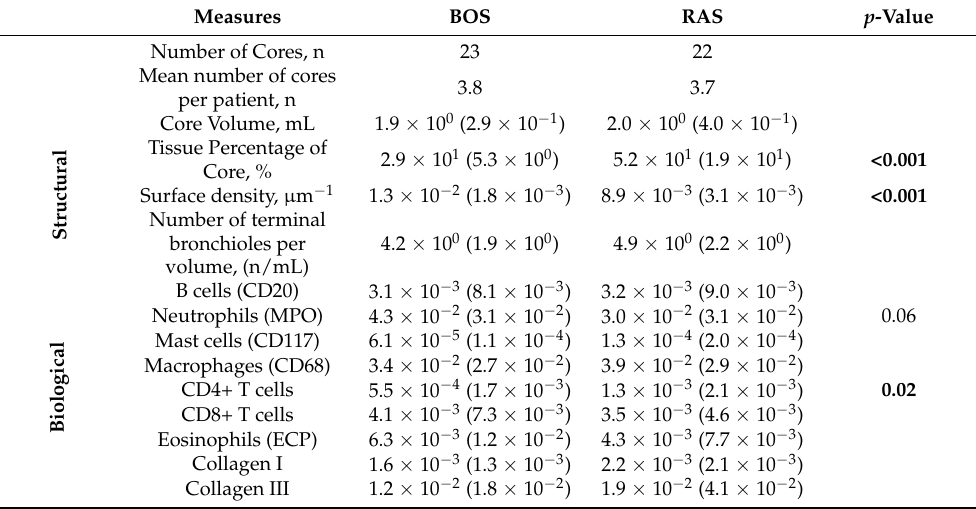
Continuous variables presented as mean (standard deviation). Group comparisons were performed using Mann– Whitney U test. Statistical significance was assessed at p < 0.05. p -values less than 0.1 are provided with significant values bolded. Tissue percentage of Core (%) was determined by normalizing the tissue volume to the core volume times 100. Biological measurements were determined by normalizing the number of positively stained cells to all identified by normalizing the number of positively stained cells to all identified cells.